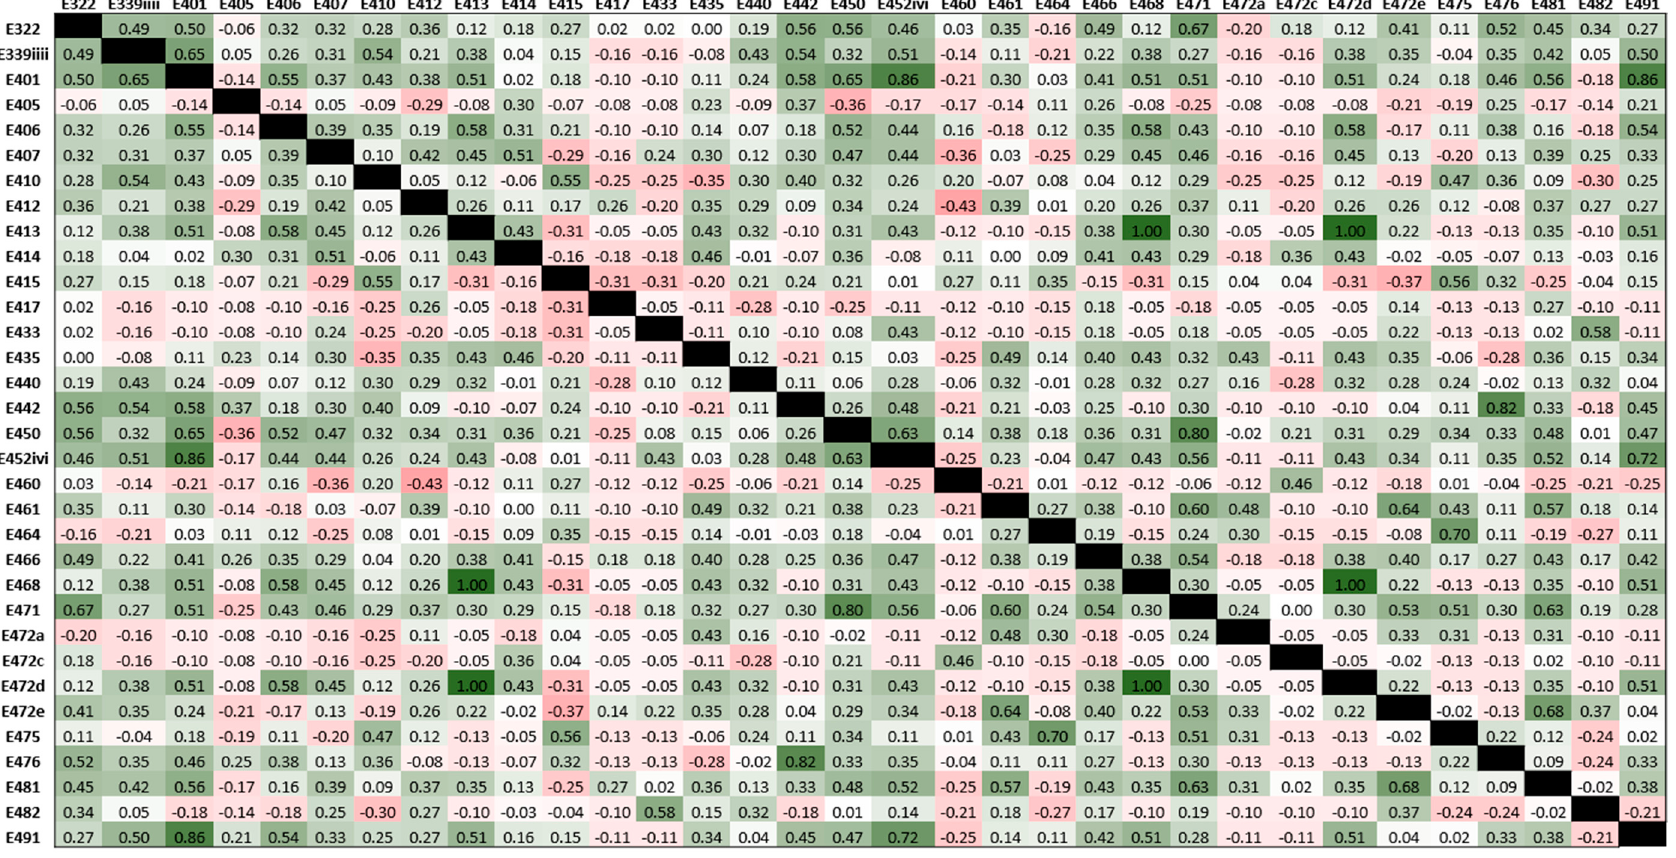
Figure 5. Heatmap showing co-occurrence of dietary emulsifier exposure of participants in the feasibility study. Values are Spearman’s rho correlation coefficients and cell shading indicate the magnitude of correlation co-occurrence between emulsifiers (green is positive correlation; red is negative correlation).